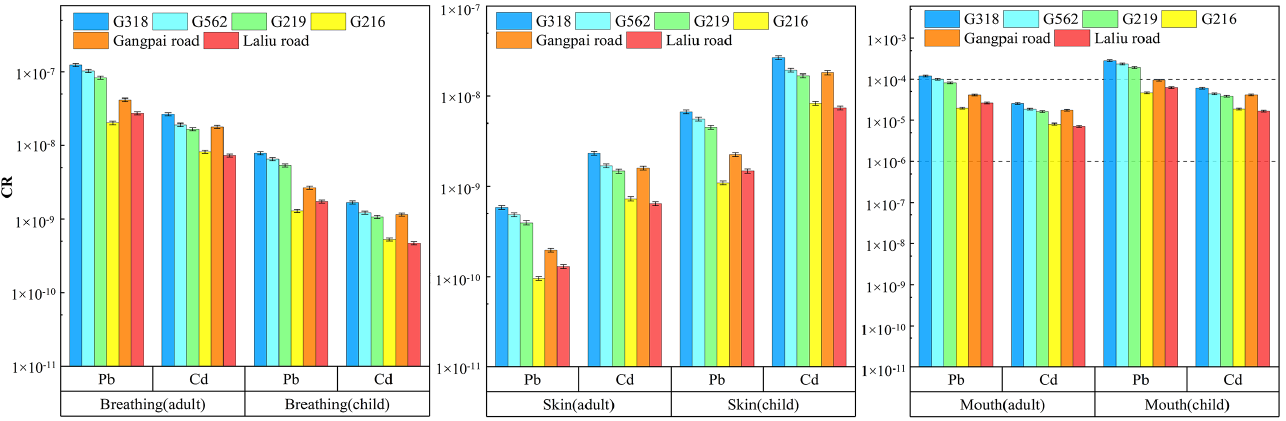
Figure 9. Carcinogenic risk from exposure to soil heavy metals near different roads for children and adults.